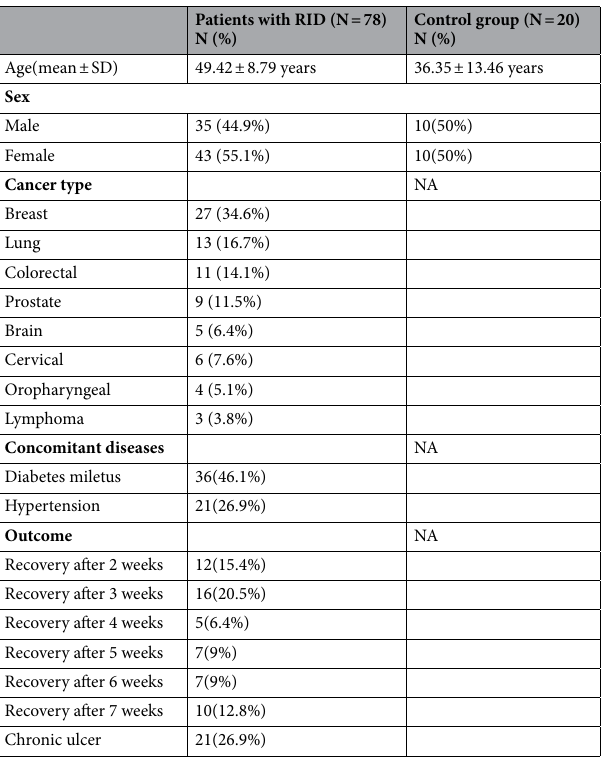
Table 1. Summary of demographic data and clinical characteristics of the individuals enrolled. N number of subjects, NA not applicable, SD standard deviation, % = percentage of all